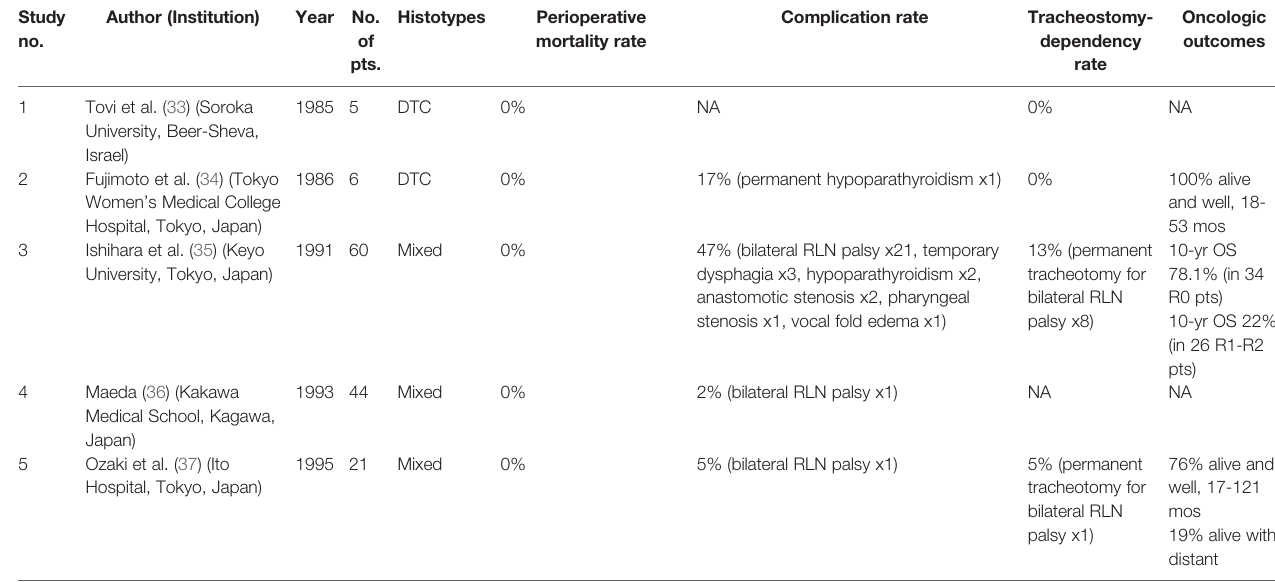
TABLE 2 | Studies included in the systematic review of English-language, non-overlapping, surgical series including ≥ 5 patients treated by (C)TRA for TC invading the airway between January 1985 and August 2021 (No. of series=37, No. of patients=656). The table reports details about TC histotype, mortality, complications, tracheostomy-dependency, and oncologic